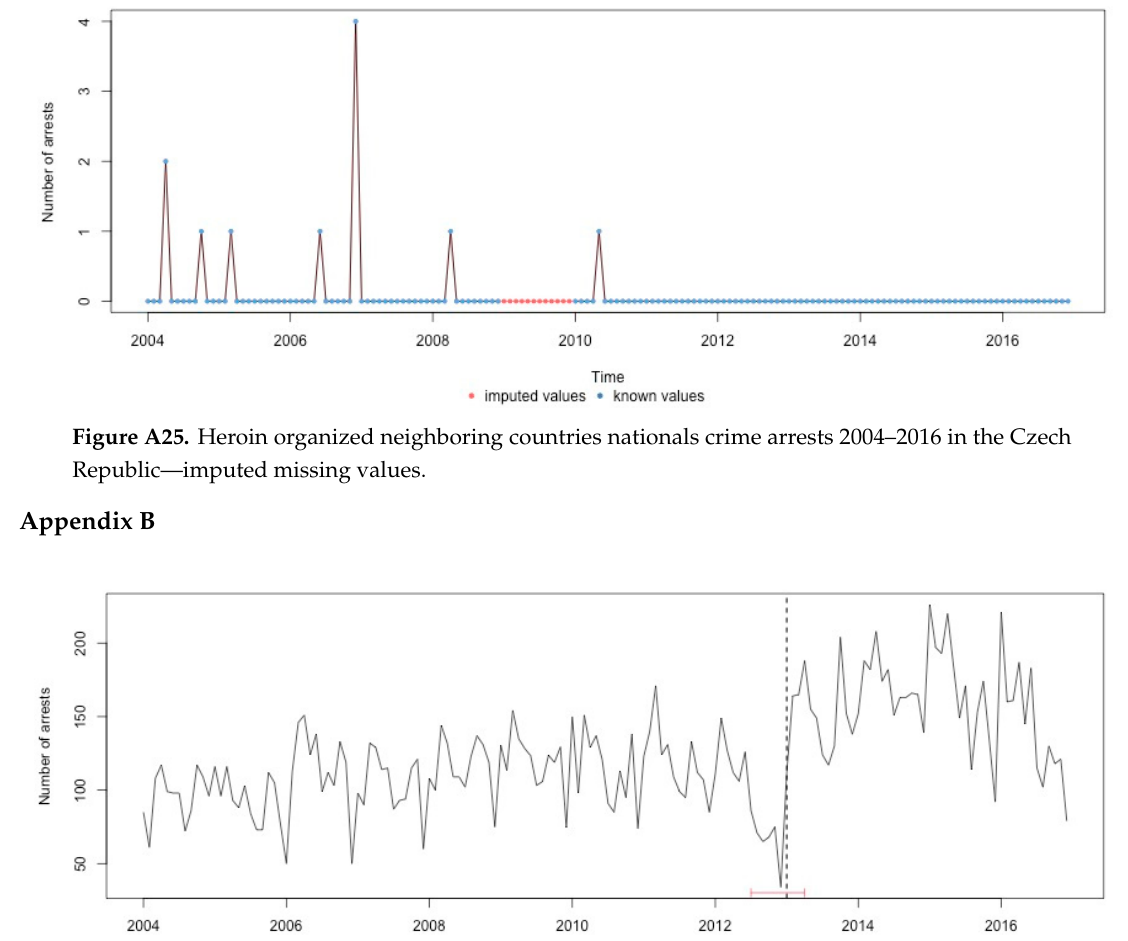
Figure A27. Methamphetamine Czech nationals arrests 2004–2016 in the Czech Republic and structural breaks.